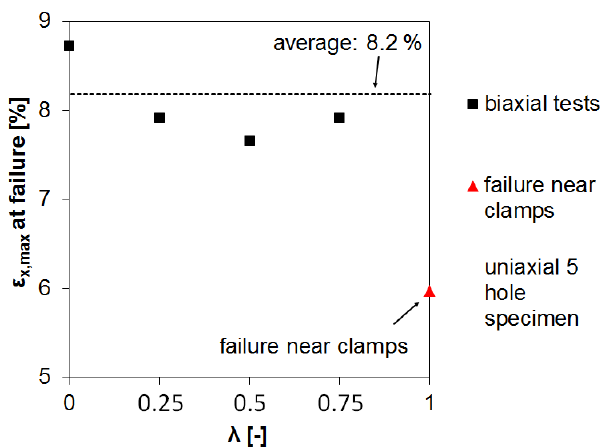
Figure 11. Maximum strains at holes just before failure computed by the FE simulation for all specimens with α = 0°.